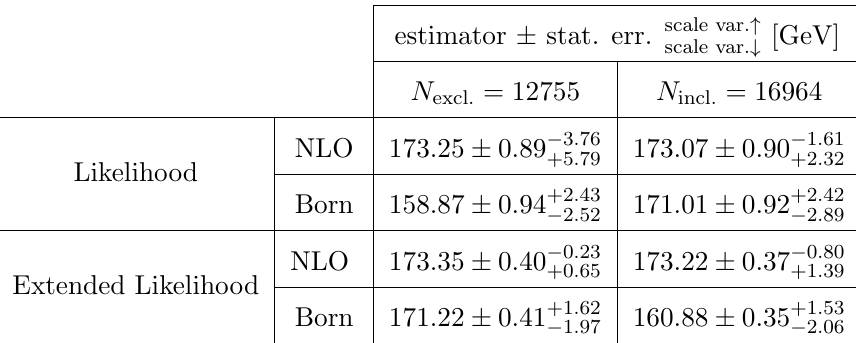
Table 2 . Extracted top-quark mass estimators from NLO s -channel events.